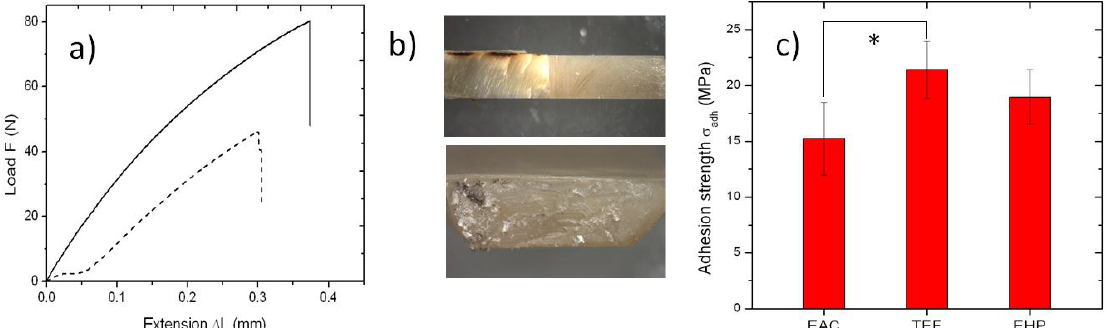
Figure 1. ( a ) Example of raw data obtained during tensile tests. In some cases ( dotted curve ) the specimen was partly slipping between the clamps, especially at the beginning of pulling; while this did not affect the maximum force measured on breaking, we discarded experiments with significant slipping; ( b ) typical optical images (not at same scale) of side view of the tooth composite specimens used (top), and broken interface in cross section (bottom); ( c ) bar plot (means ± one standard deviation) of the adhesion strength for all the three composites considered. The asterisk represents statistically significant differences, (*: p < 0.05).